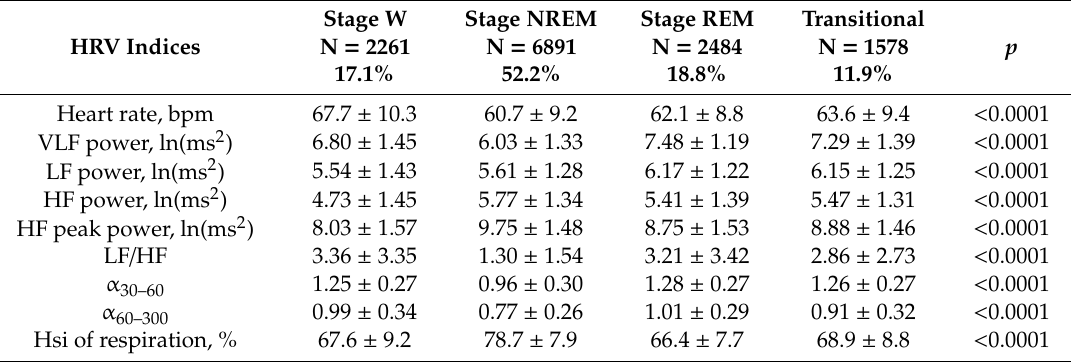
Table 2. Sleep stage and indices of heart rate variability (HRV).